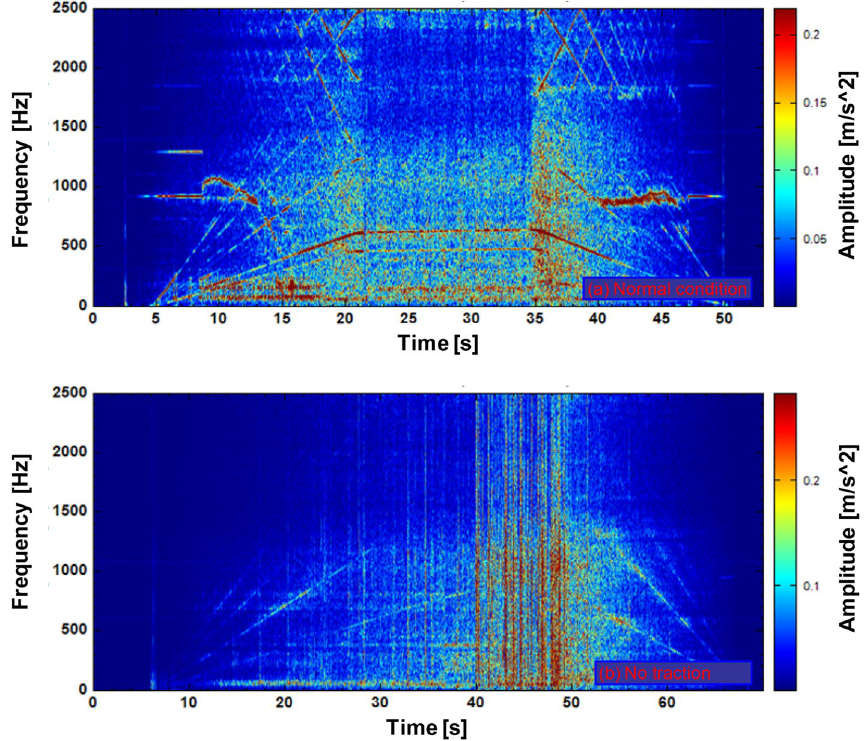
Figure 19. Pinion vertical vibration, (a) under normal condition, (b) with no